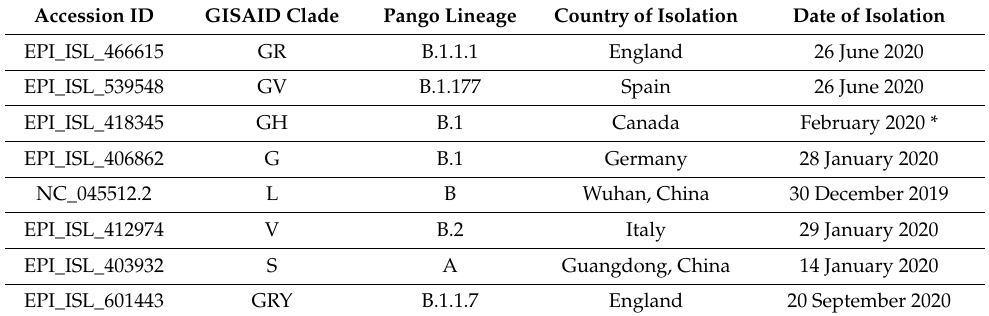
Table 1. Details of the SARS-CoV-2 reference sequences (global) used for phylogenetic analysis. Note: * Exact date of isolation is not available for this